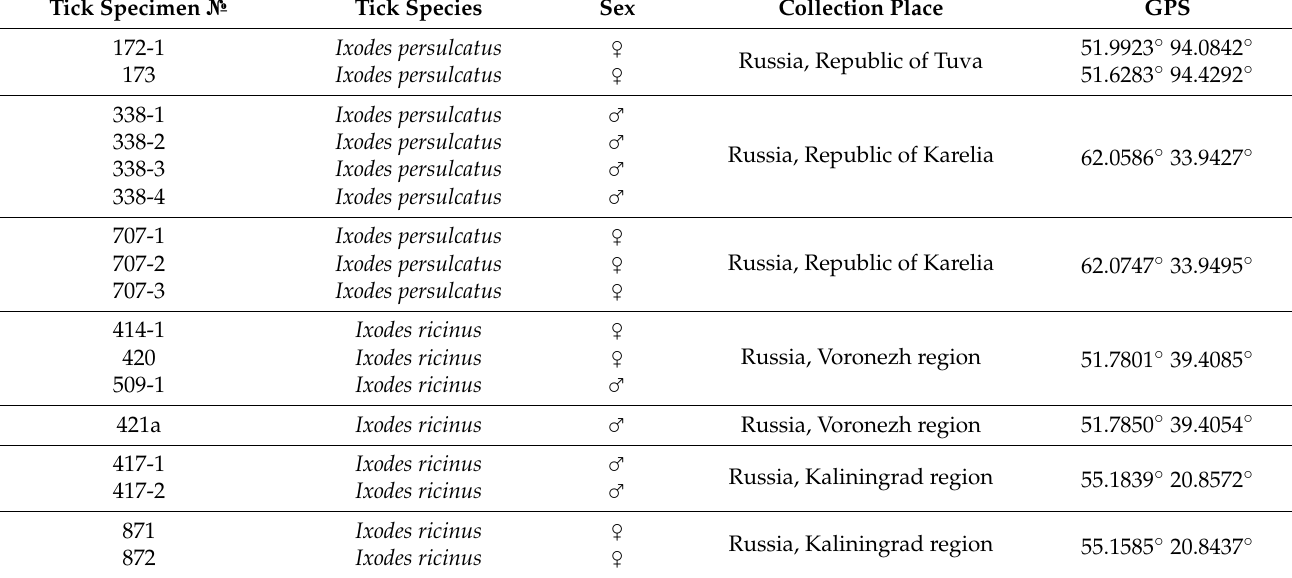
Table 1. Non-hybrid ticks used in the